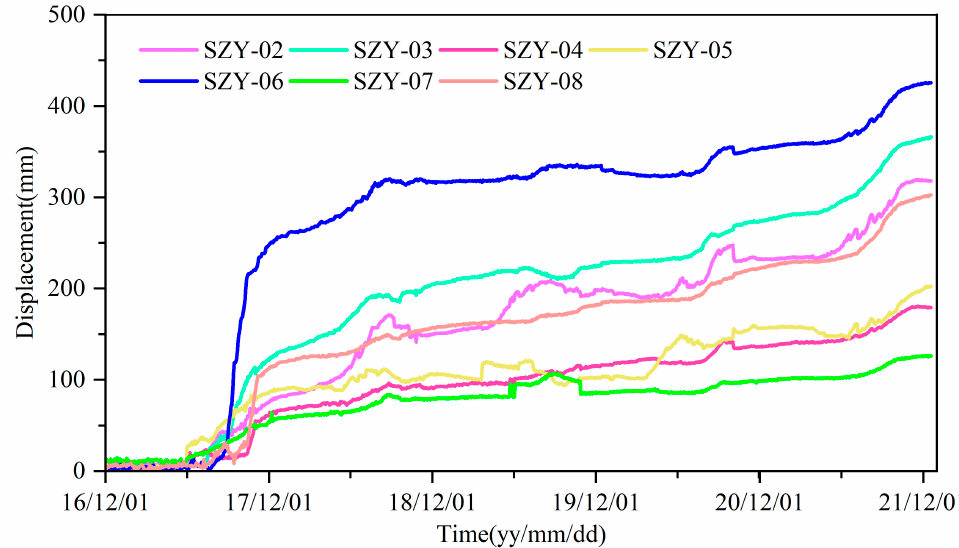
Figure 3. Landslide displacement monitoring data.